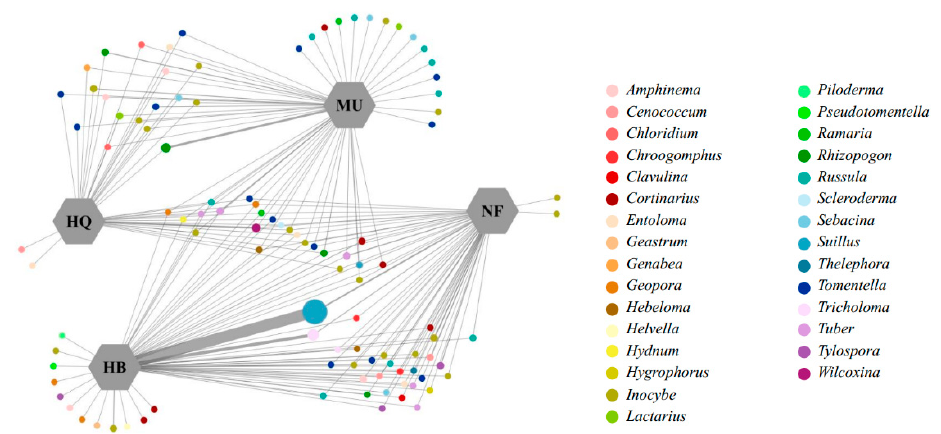
Figure 3. Network of EM fungal operational classification units (OTUs) in each P. sylvestris stand across three sandy lands. Circle size represents absolute OTU abundance. Line thickness represents relative OTU abundance in sandy land.